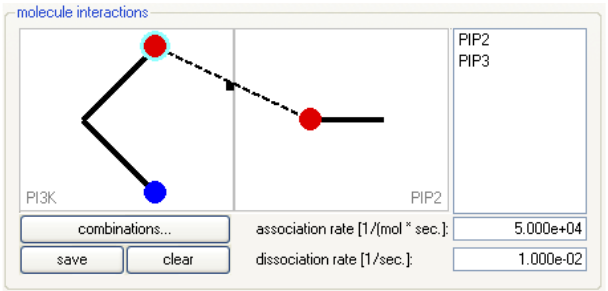
Figure 3. Defining Quantitative Interactions between Molecular Binding Sites Using Simmune (Screenshot) The screenshot of Simmune’s modeling interface shows the graphical representations of PI3K and PIP 2 and the binding sites through which they interact, as well as the sites of membrane attachment. The turquoise circle around the upper binding site of PI3K identifies it as an enzymatically active site. The dotted line represents the possibility of a binding interaction between these two molecules. Selecting the interaction by clicking on the handle on the dotted line allows entry of the relevant binding